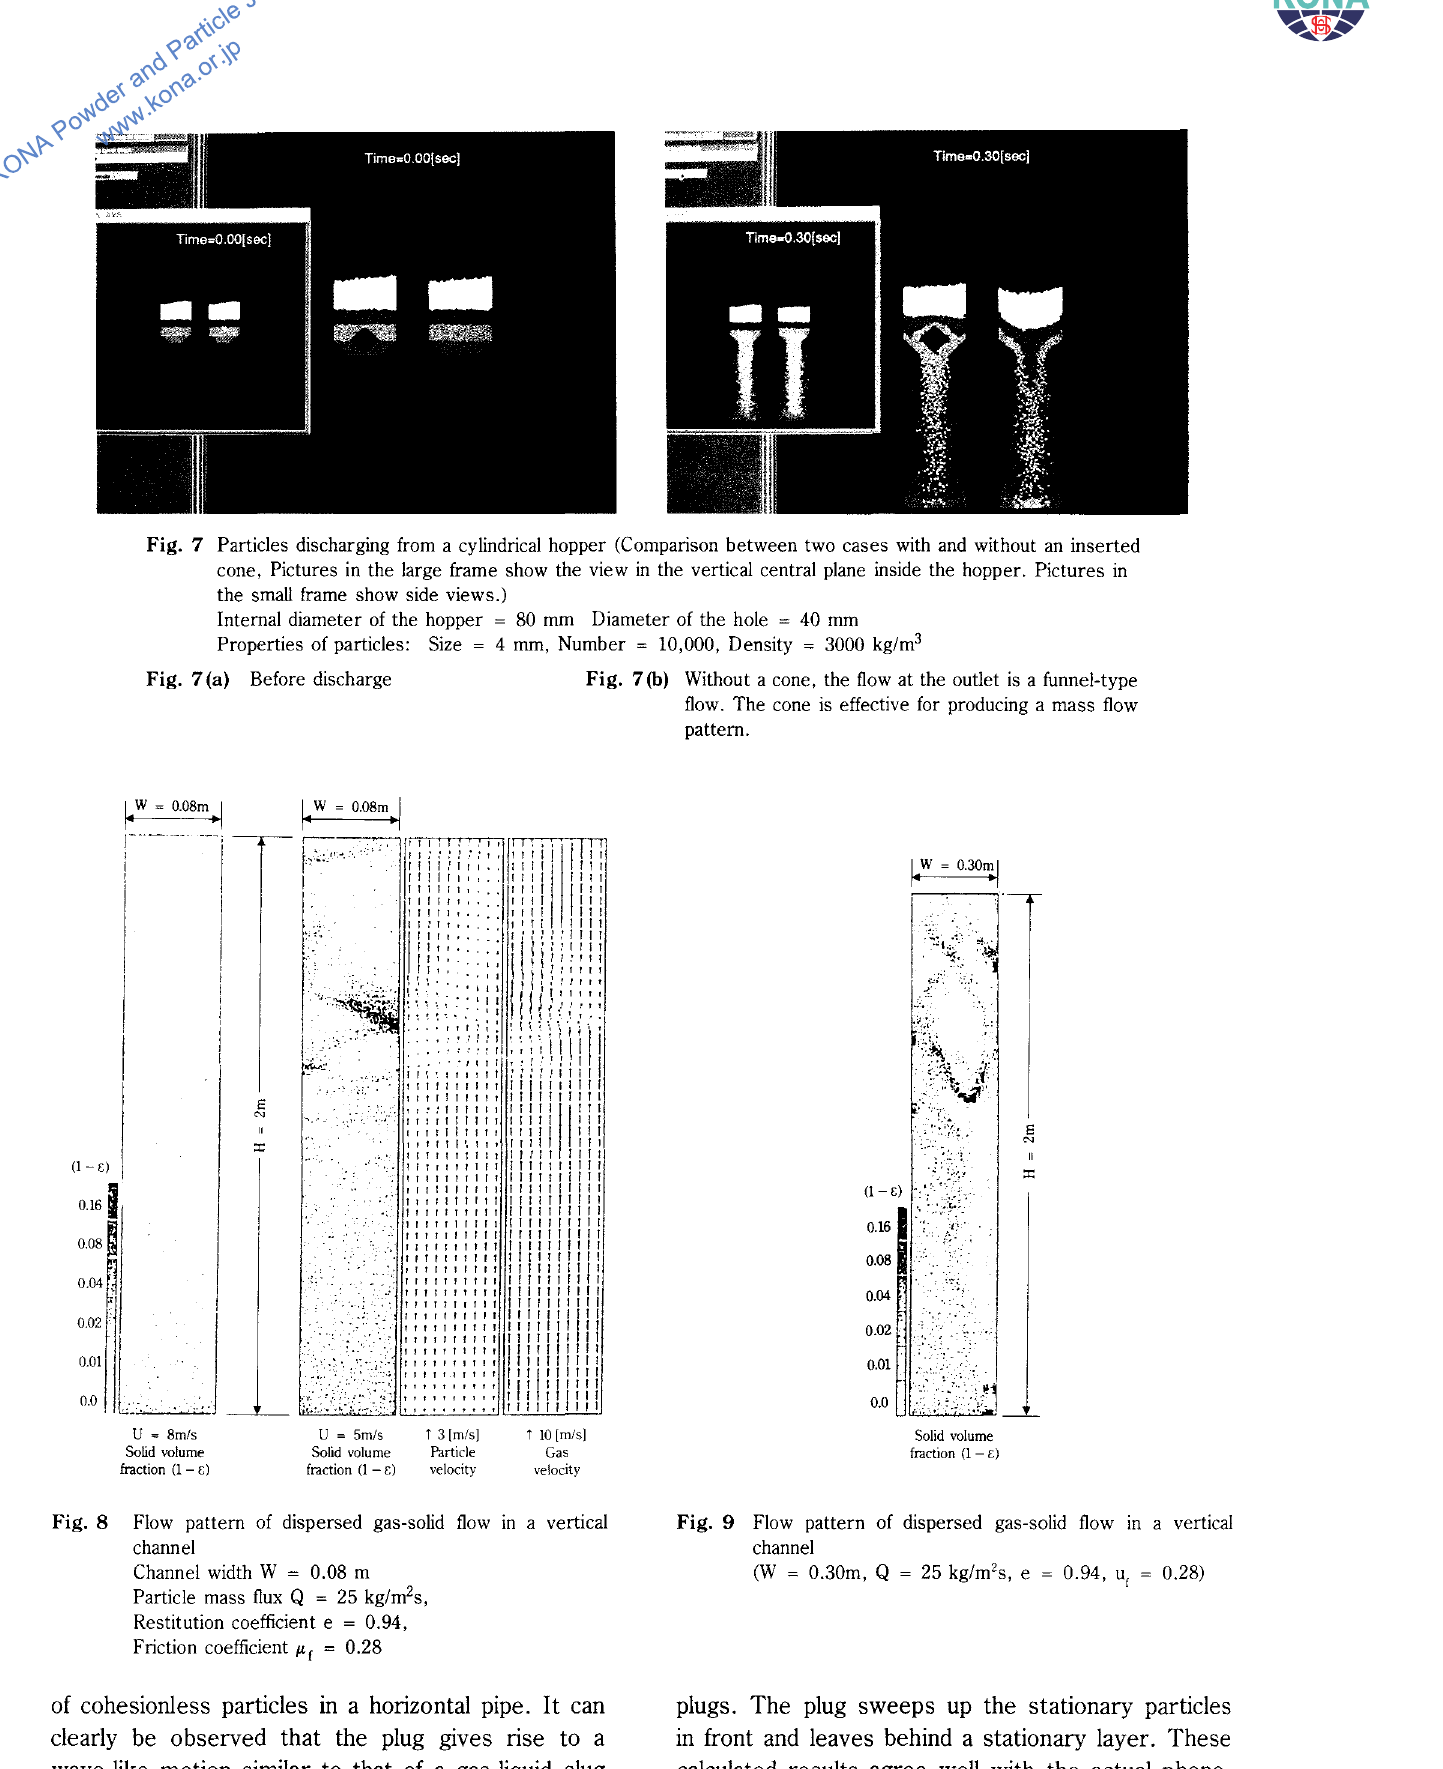
Fig. 9 Flow pattern of dispersed gas-solid flow in a vertical channel